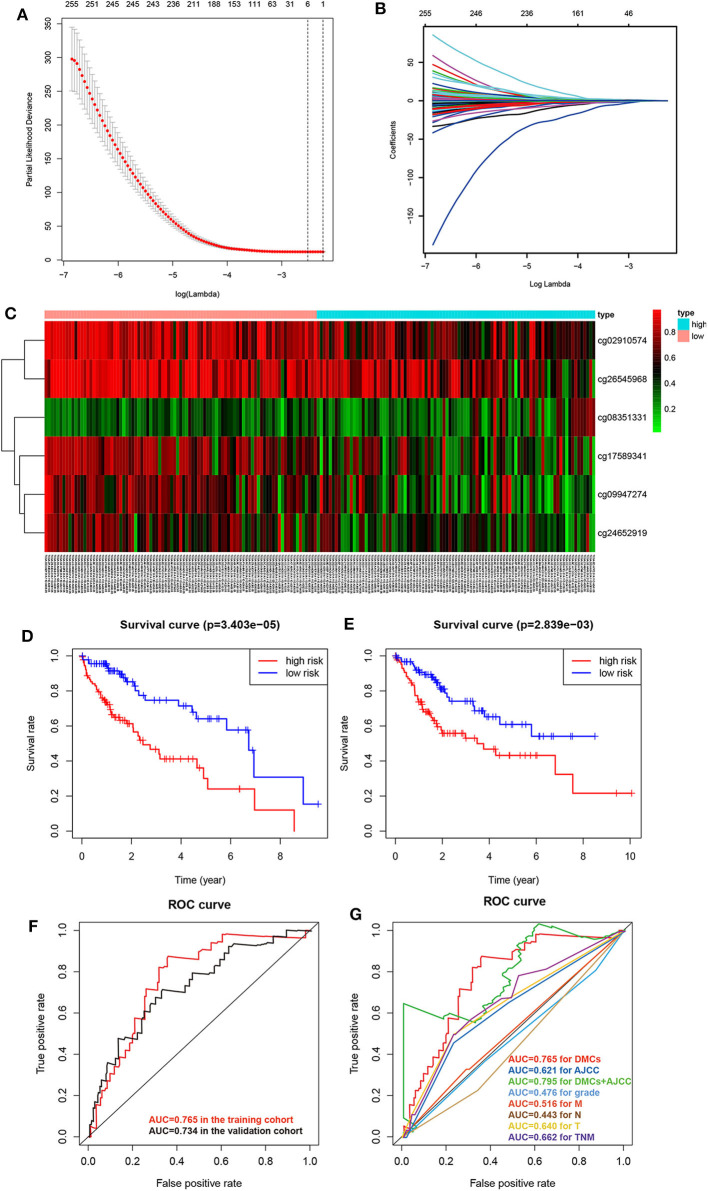
Establishment of the prognostic model of six DMCs in the training cohort (n = 183) from the LIHC cohort of TCGA. The cross-validation error curve shows the regularization path of the least absolute shrinkage and selection operator (LASSO) algorithm. The elimination of non-informative genes was visualized by decreasing prediction error to a minimum (black dotted line) with only the six most important DMCs left in the Cox proportional hazards model (gray shaded area = 5–95% confidence interval) (A). LASSO regression analysis was performed to select radiomic features for prognostic model building for HCC patients. Feature coefficients were plotted against the shrinkage parameter (lambda) (B). Heatmap of the six DMCs in the training cohort. Rows represent differentially methylated CpG sites, and columns represent samples; light blue and pink represent high and low β values of CpG sites, respectively (C). To assess the prognostic value of the six-DMC model, overall survival was analyzed in the training cohort (D) and the validating cohort (E). The red line and the blue line represent the patient groups with high- and low-risk scores, respectively. Receiver operating characteristic curve analysis was performed to assess the prognostic accuracy of the six-DMC model in the training cohort and the validating cohort (F). The prognostic accuracy of the DMC model was further assessed by comparing it to other prognostic clinicopathological parameters, and the value of the AUC for each model is shown. Different colors represent different parameters and models, and the AUC values are depicted with the same color as the models (G).